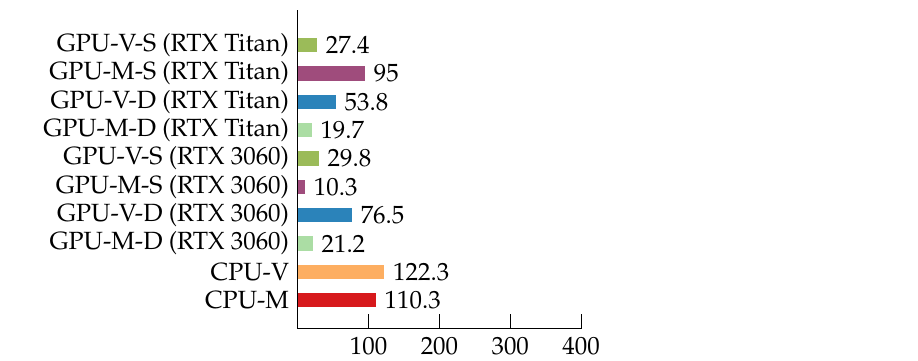
Figure 22. Comparison between the execution times ( × 10) obtained for the nano-waveguide simulation.